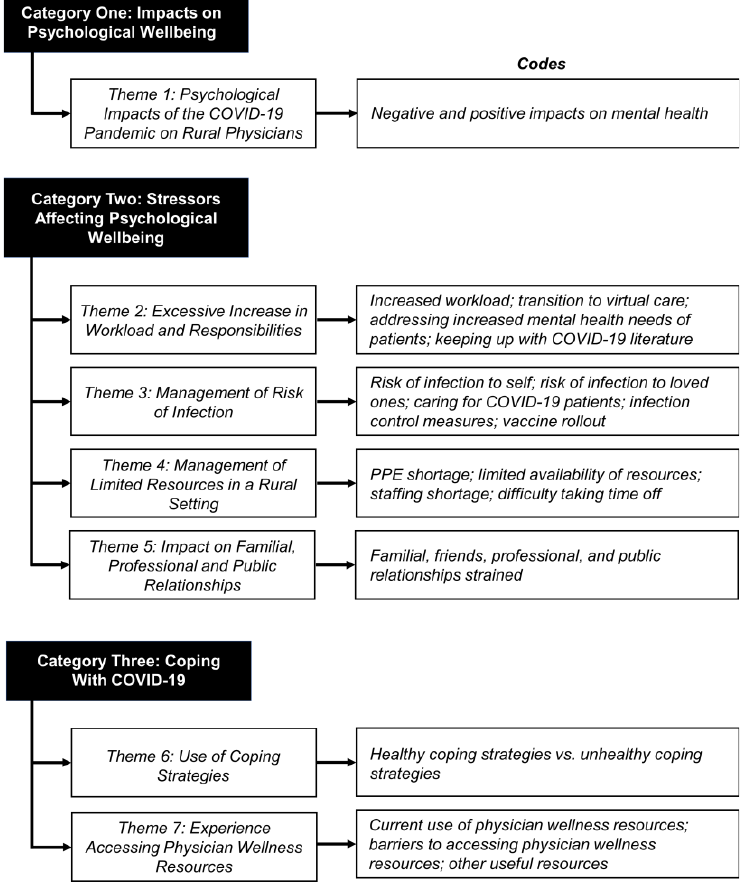
Figure 1. Qualitative thematic analysis with categories, themes, and associated codes.